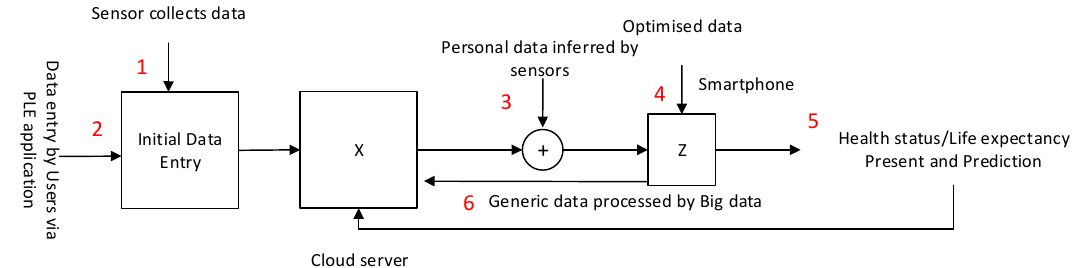
Figure 6. Information flow of health data creation. Initial data are entered by users using their smartphone apps, and optimized data from the cloud server are sent back to the app for fine-tuned prediction.